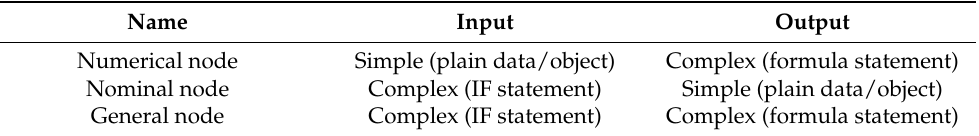
Table 2. The three types of nodes as interpreted by the compiler, with the first two being particular cases of the third